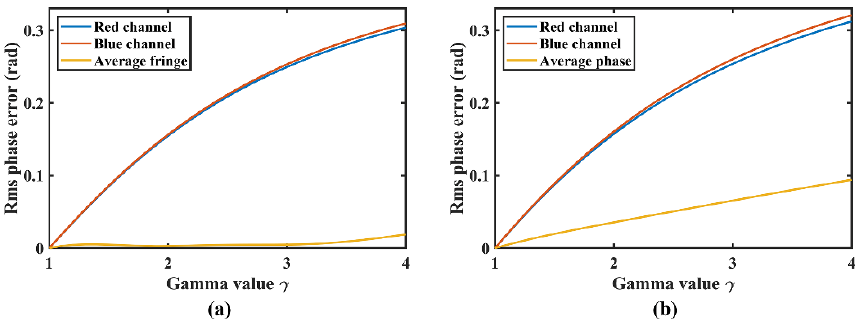
Figure 5. Rms phase errors under different gamma values when using ( a ) the proposed IDTP algorithm and ( b ) the conventional PDTP algorithm.